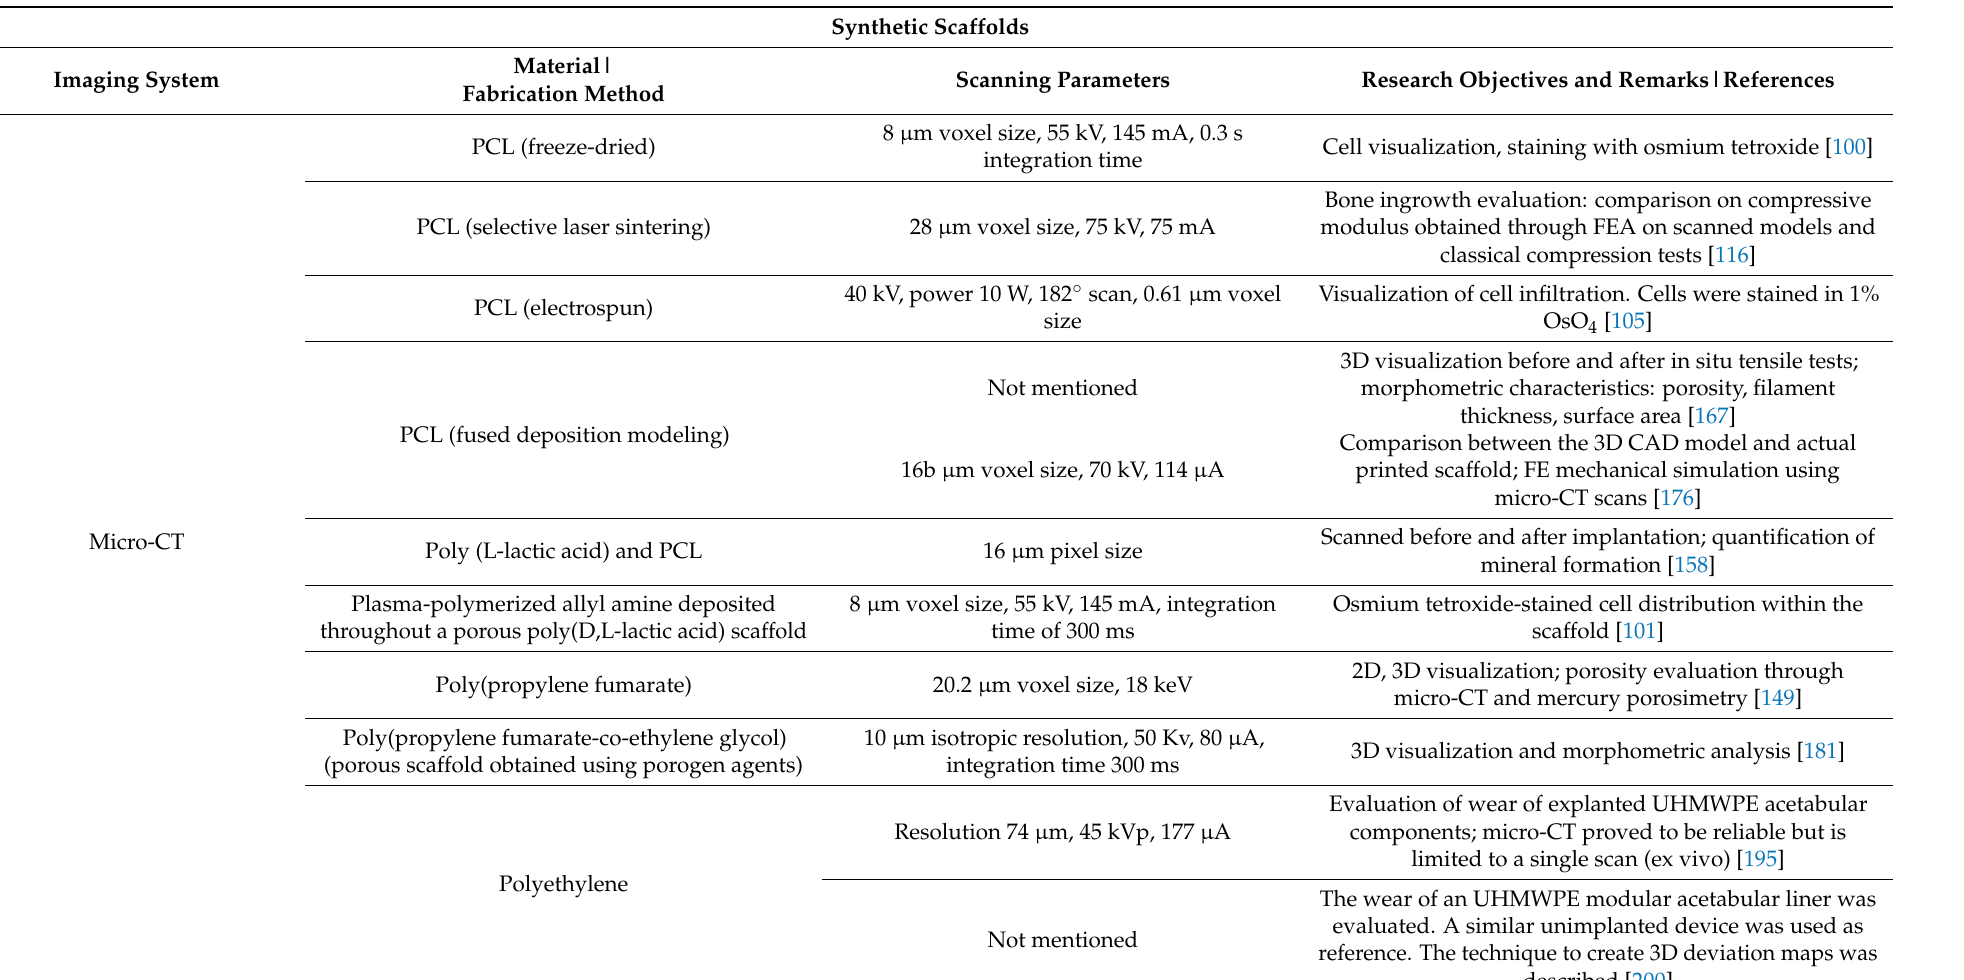
Table 1. Summary of CT applicability in characterizing scaffolds with biomedical